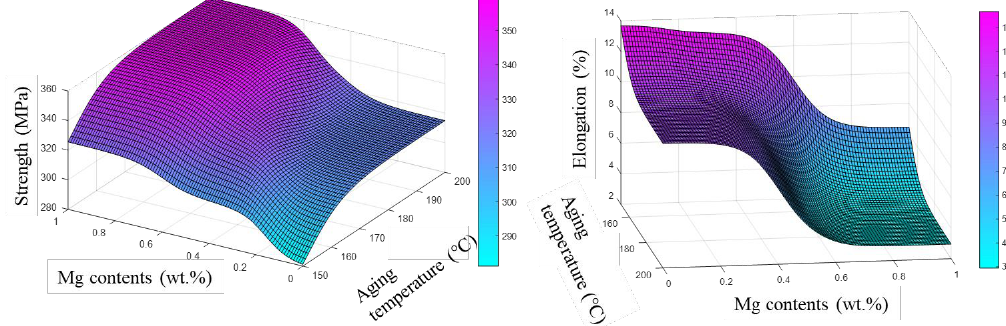
Figure 7. Predicted mechanical properties with Mg content and aging temperature.